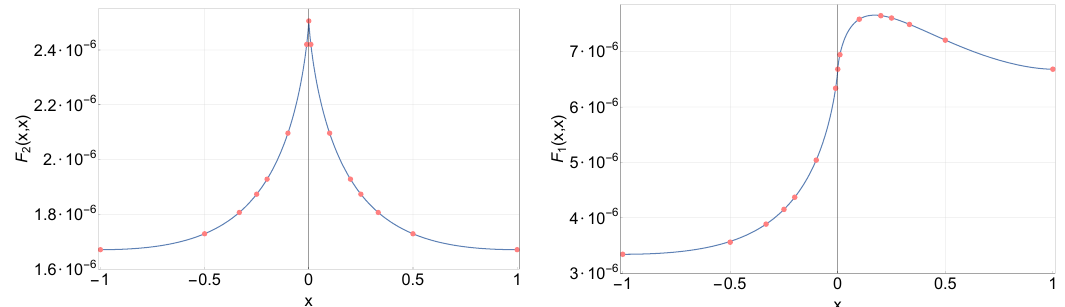
Figure 3. Plots of the F -functions for the 2 -channel (left) as well as for the 1 -channel (right). In both cases, the dots correspond to the data gathered by numerical integration, while the solid lines show the collinear limit of eq. (3.11) for the 2 -channel (left) and the resummation of the 1 -channel as given in eq. (4.13) (right). For both channels we observe a perfect agreement between numerical data and analytical